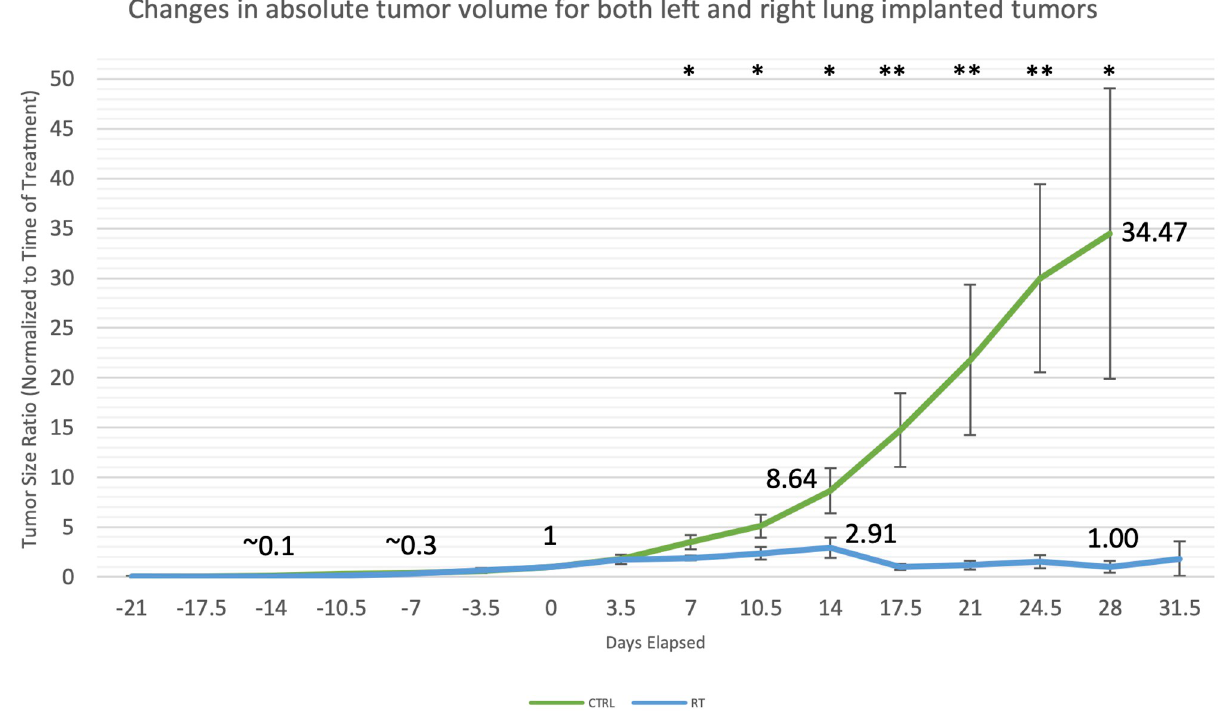
Fig 5. Graph of tumor response in CTRL and RT animals. Graph contains both left and right implanted tumor responses as they performed similarly. Tumor volumes normalized to tumor volume at the time of treatment are aligned based on date of sham RT or RT treatment (Day 0). Animals were separated into non-treated (CTRL—green line) and RT treated (RT—blue) with 14 and 13 animals in each group, respectively. The asterisk indicates the p value of the computed Mann-Whitney test as being p < 0.05 ( * ) or p < 0.005 ( ** ) between the CTRL and RT groups.